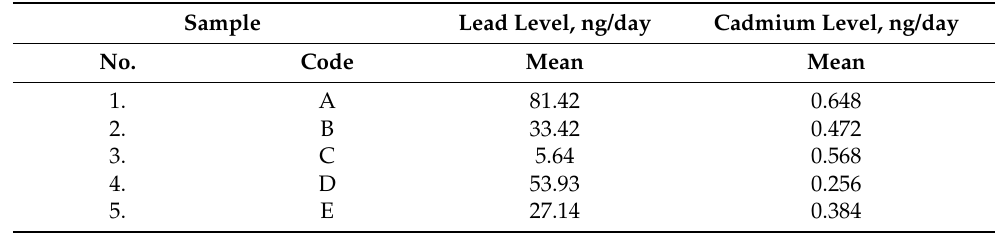
Table 3. Daily external exposure of investigated HMIs in analyzed pharmaceuticals (ointment,